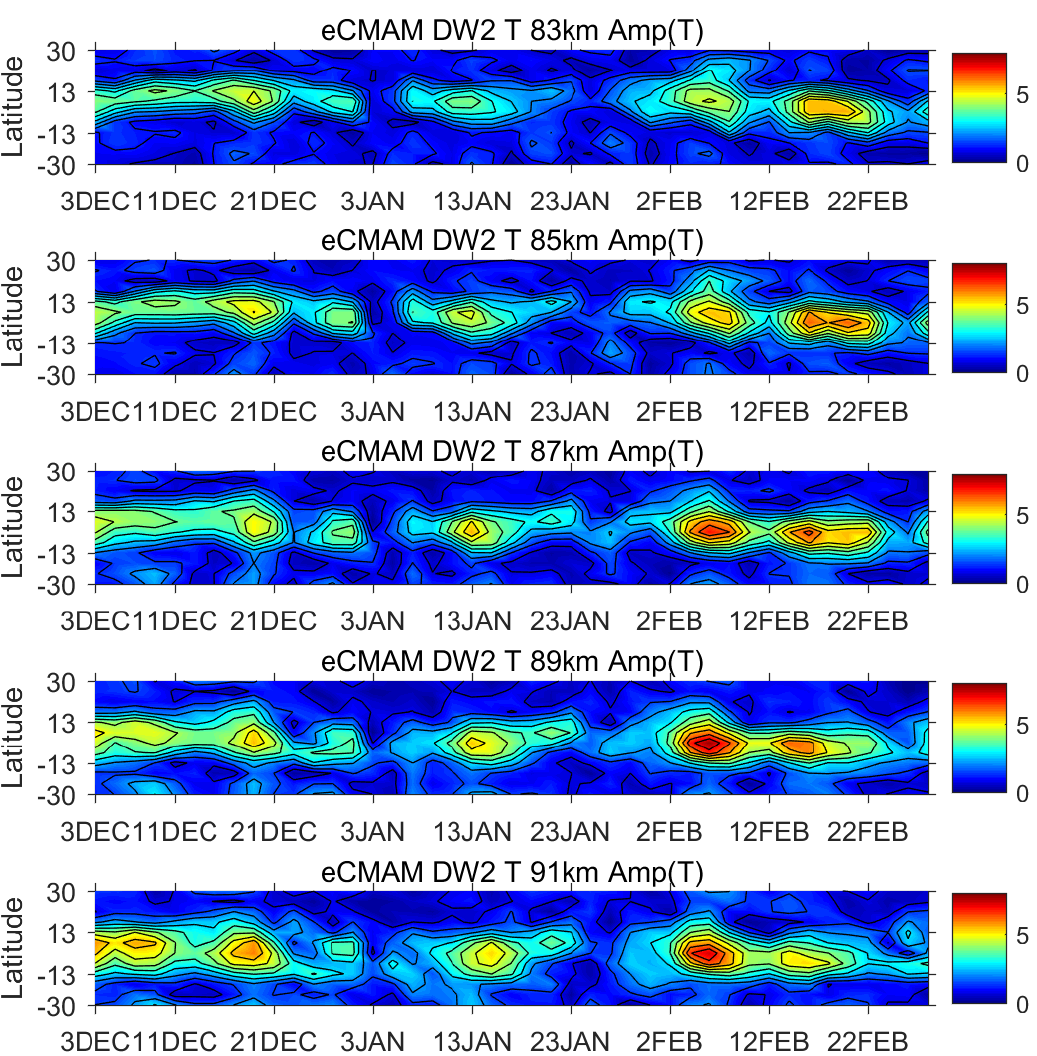
Figure 3. Same as Figure 2, but for the DW2 T field at 83, 85, 87, 89, and 91